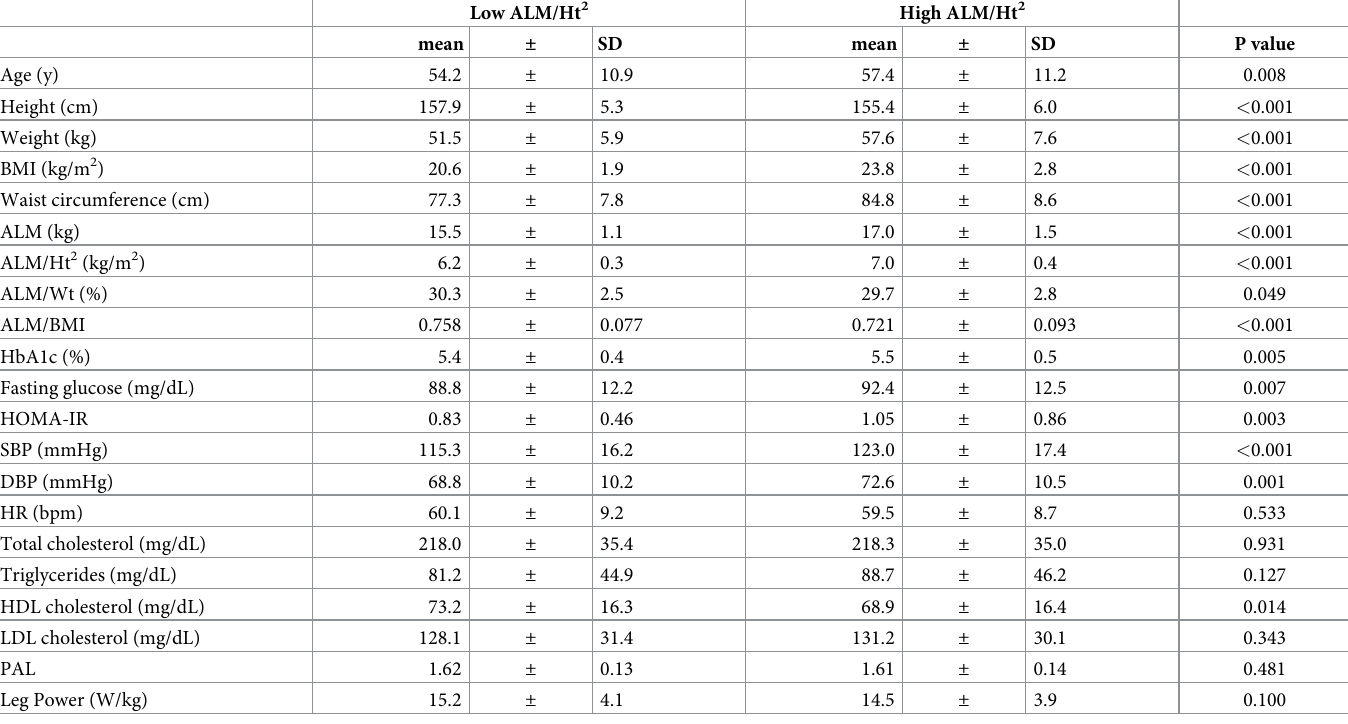
Table 3. Baseline characteristics of the study participants according to relative ALM against square height (N =